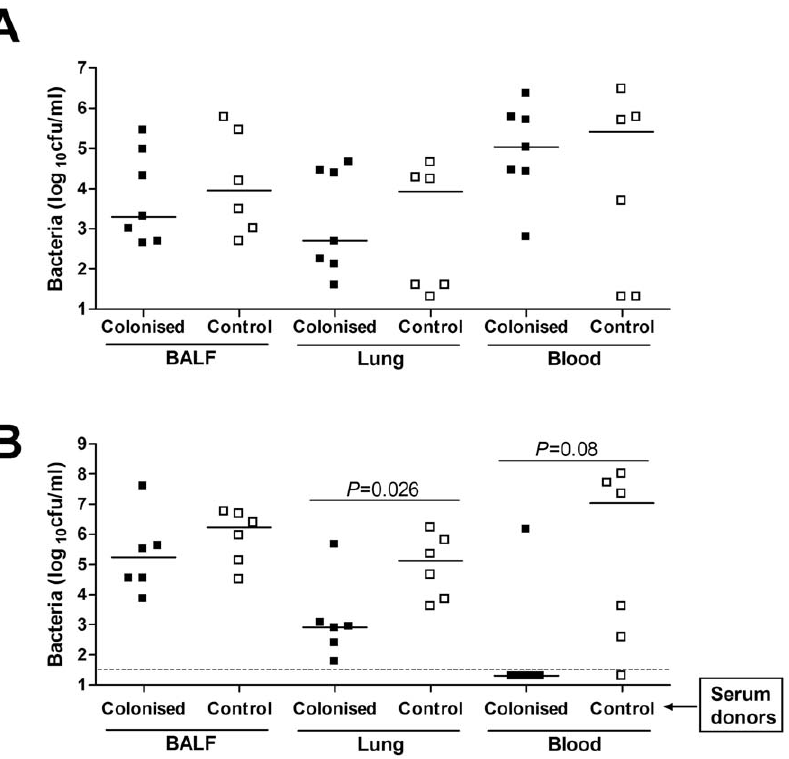
Figure 7. Role of antibody in the effect of prior colonisation on subsequent pneumonia. (A) Bacterial cfu in BALF, lung and blood of colonised or control m MT mice 18 h following pneumonia challenge. (B) Bacterial cfu in BALF, lung and blood of passively immunised CBA/Ca mice 18 h following pneumonia challenge. Mice received pooled serum collected from either colonised or control CBA/Ca mice prior to challenge. Each symbol represents results for an individual mouse and bars the median for each group. The dotted line is the limit of detection. Lung cfu are compared between groups by Mann-Whitney U-test. Presence or absence of bacteraemia was assessed by Fisher exact test.